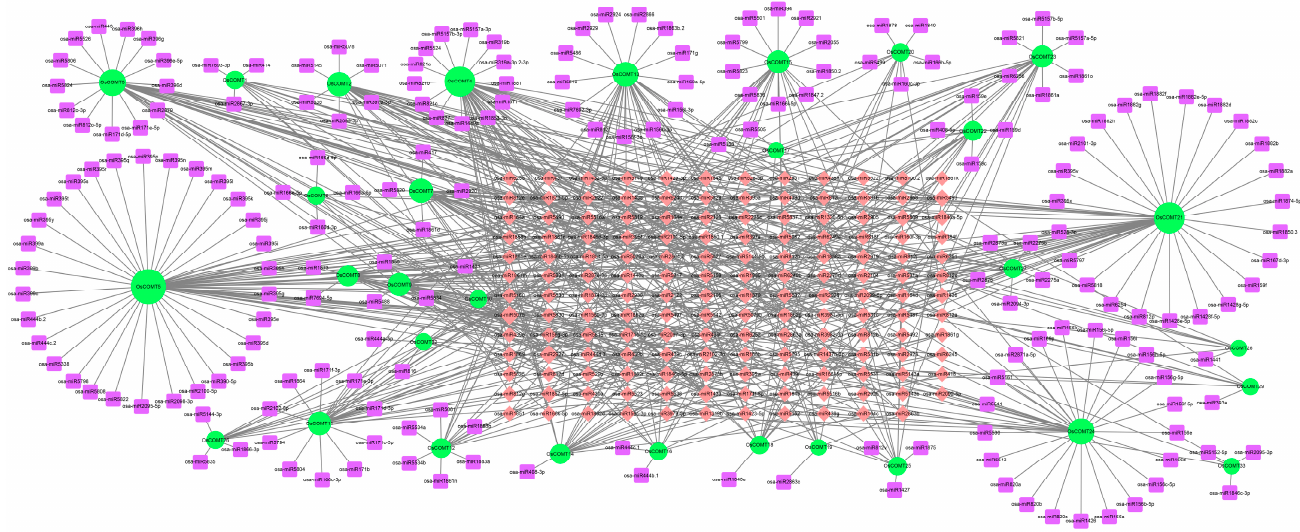
Figure 9. Network diagram of miRNAs targeted with OsCOMTs . OsCOMTs are marked in green. Single-targeted miRNAs are marked in purple, and multi-targeted miRNAs are marked in pink.